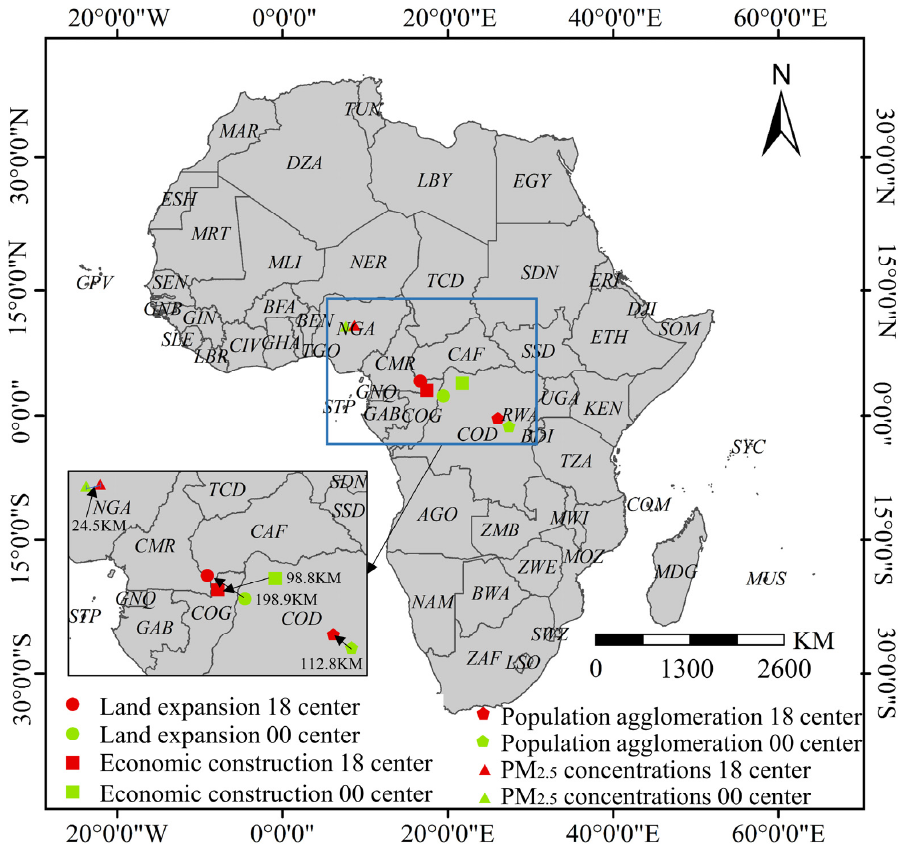
Figure 9. The evolution of the gravity center of PM 2.5 concentrations and multi-dimensional urban- ization in 2000 and 2018; for calculation formula, see Li et al. (2019) [48].